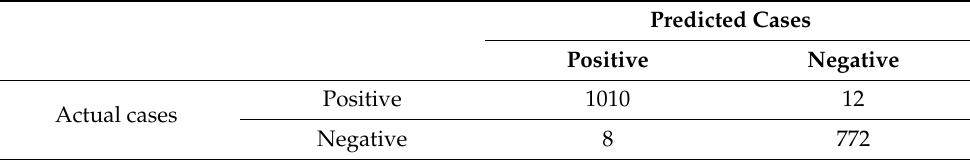
Table 5. The confusion matrix denotes the accuracy of the model using the SV-S2017